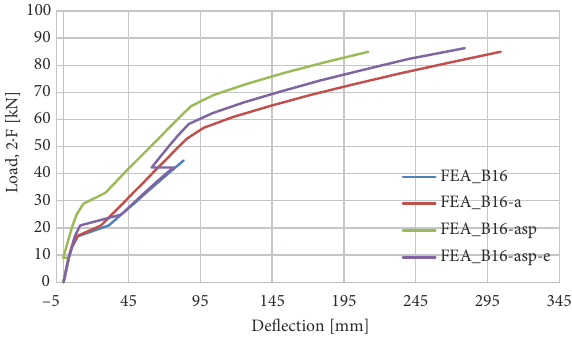
Fig. 3. External load vs deflection curves, predicted numerically. Reinforcement 4 ∅ 16